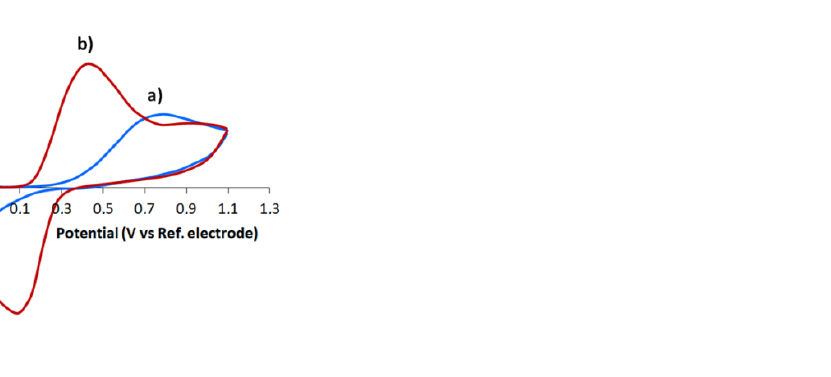
Figure 3. Cyclic voltammograms of 1.0 mM [Fe(CN) 6 ] 4− on CVE ( a ) and CVE act at 2.0 V ( b ) in 0.1 M KCl. Potential scan rate 0.05 Vs −1 .